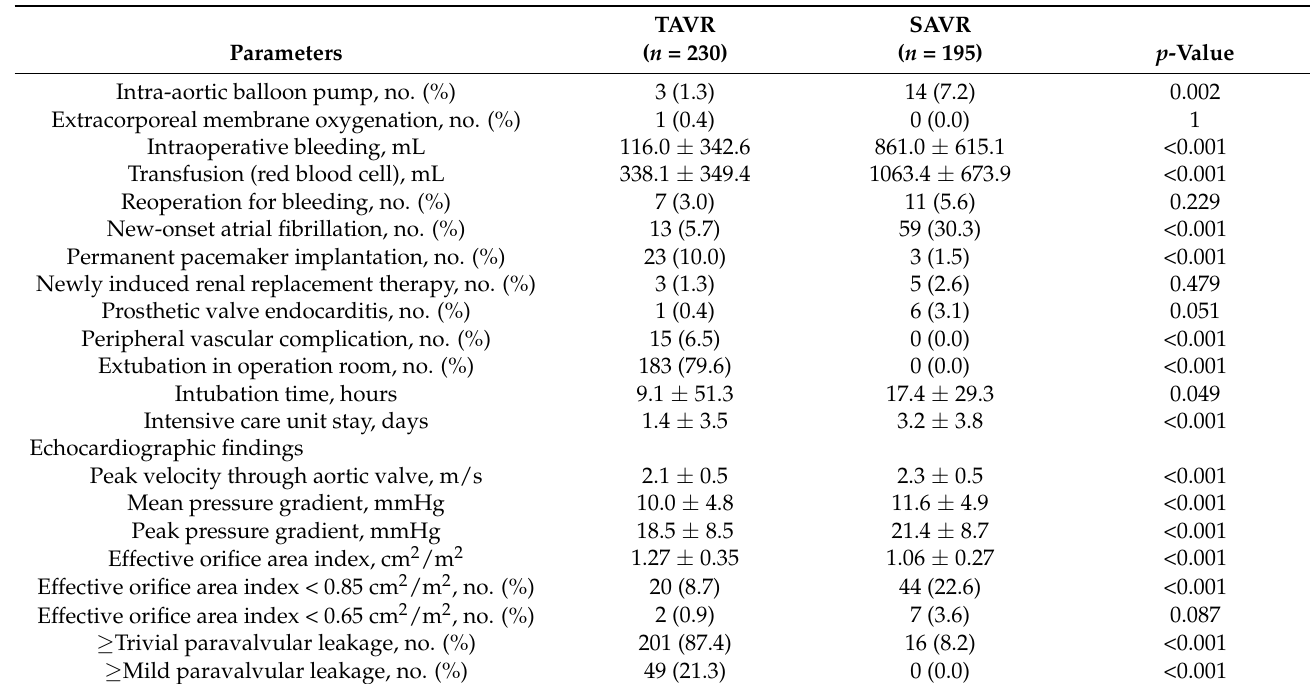
Table 3. Clinical